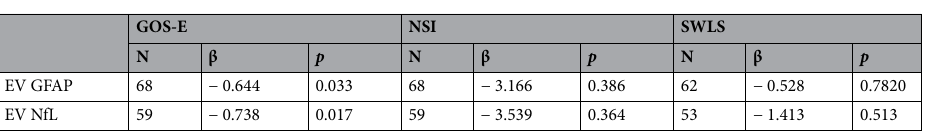
Table 2. Linear model of 1 year outcomes and biomarker concentrations, controlling for age and sex. GOS-E Glasgow Outcome Scale-Extended, NSI Neurobehavioral Symptom Inventory, SWLS Satisfaction with Life Scale, NfL neurofilament light, GFAP glial fibrillary acidic protein, EV extracellular vesicle.